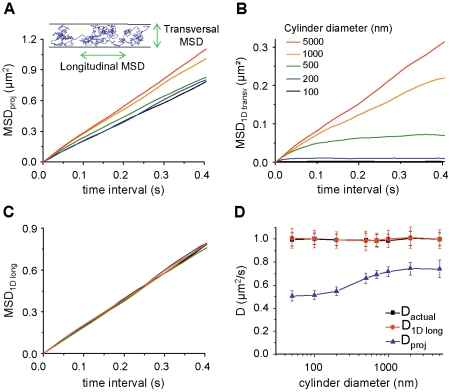
Unbiased D calculation using the displacements in the direction of the cylinder axis.
A–C) Examples of MSD plots of projected trajectories (A) and their corresponding MSD1Dtransv (B) and MSD1Dlong (C) for the indicated cylinder diameters. Trajectories were simulated with a diffusivity of 1 µm2/s. Inset in A: the projection of each simulated trajectory was decomposed into two components: parallel and perpendicular to the cylinder axis. These components were used to calculate the longitudinal (MSD1Dlong) and transversal (MSD1Dtransv) MSD. D) Effect of cylinder diameter on the values of Dactual, Dproj or D calculated on MSD1Dtransv (D1Dlong), for trajectories simulated with a diffusivity of 1 µm2/s (mean ± SD, n = 50).